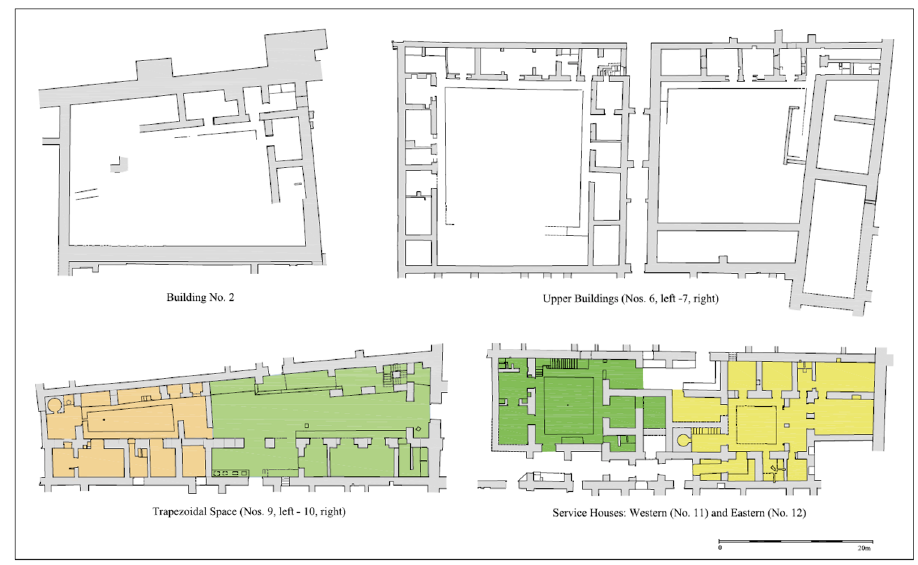
Figure 13. Buildings for the Qas.r overseers and servants. Own elaboration on the plan of Vallejo Triano (2016a, Figure 2).